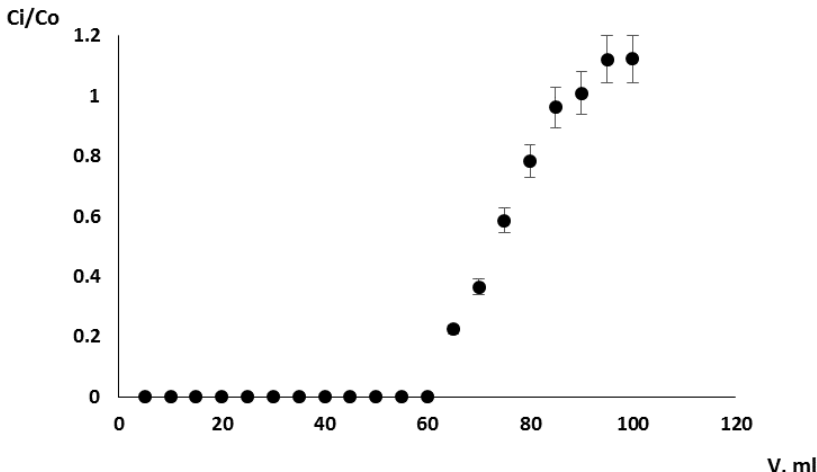
Figure 7. Frontal dynamic elution curve for Ag(I) in system (0.1 M HNO 3 ; V = 5 mL · min − 1 , and m(sorbent) = 0.1 g), (n = 4, p = 0.95).